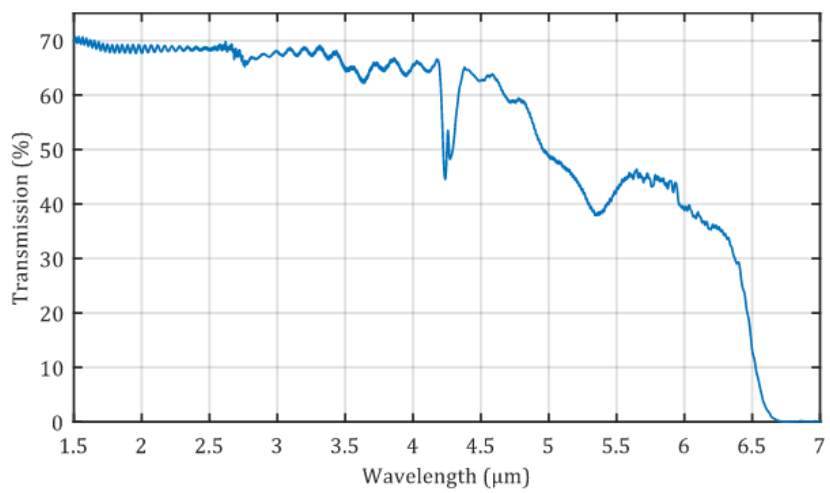
Figure A1. Background-compensated infrared transmission spectrum of the photoacoustic transducer. A characteristic dip at 4.26µm indicates the presence of a high concentration of CO 2 inside the cavity of the